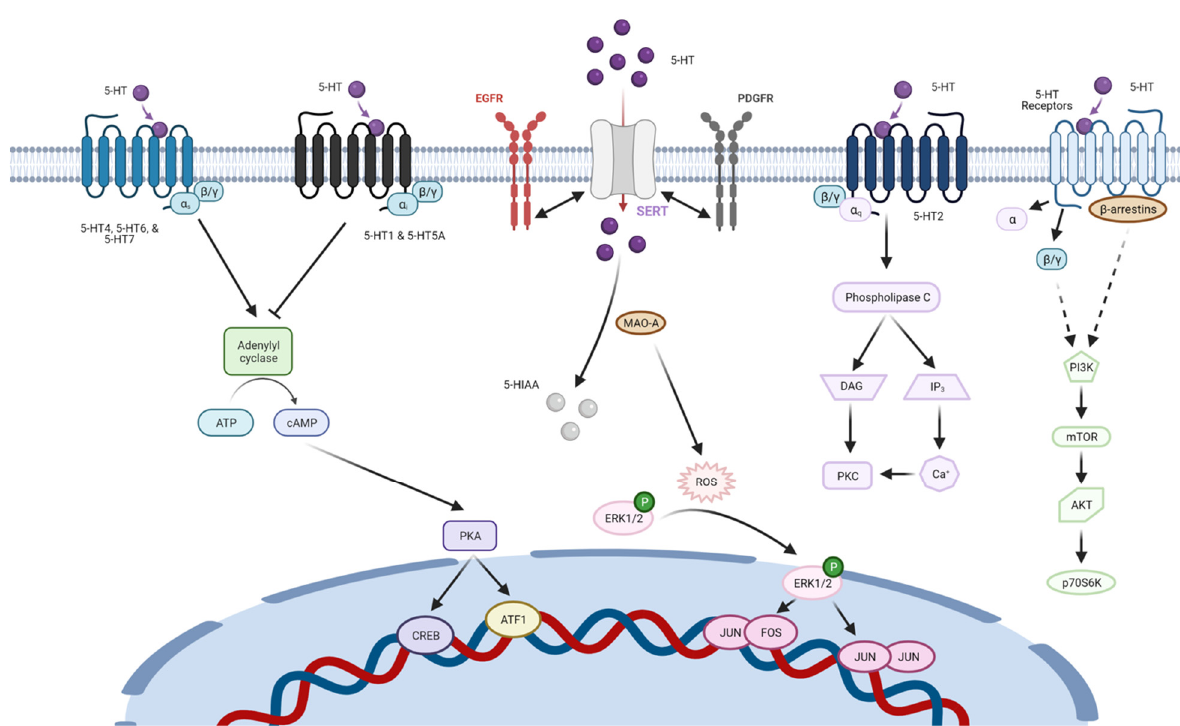
Figure 3. Overview of serotonergic signaling. Schematic displaying canonical and noncanonical signaling pathways coupled to serotonergic signaling proteins.